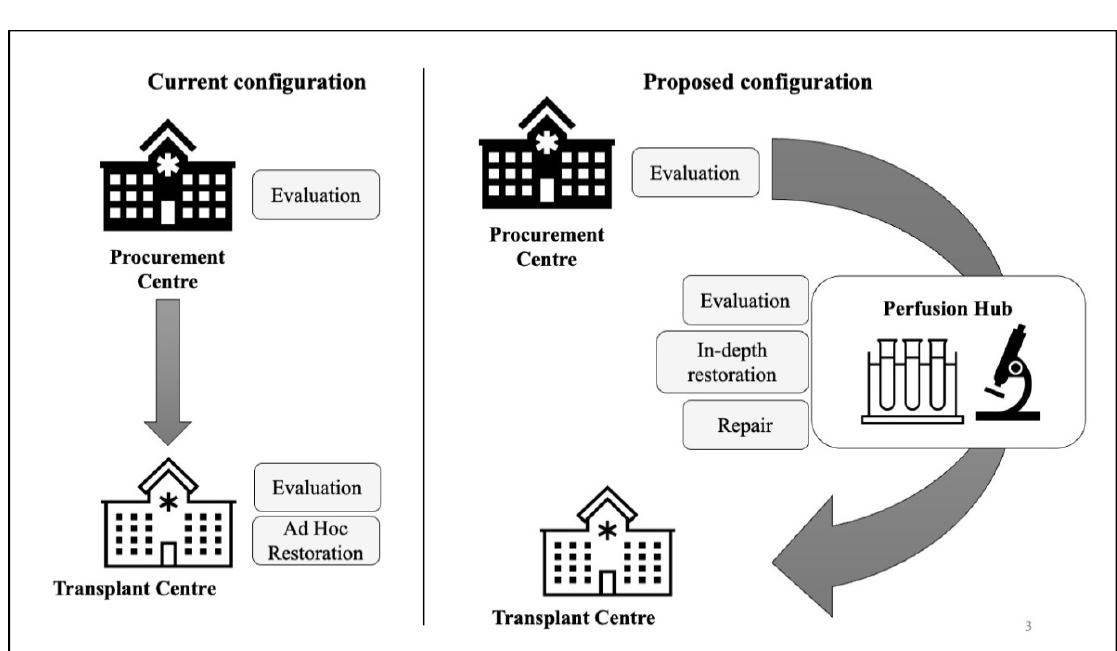
Figure 5. Proposed organ-management algorithms for transplantation. Top : Decision-making algorithm based on the quality of the organ to be transplanted. Depending on the quality of the organ, and thus its degree of damage, it could be directed towards adapted management protocols, notably at the level of the donor in the event of characterization of this quality as soon as brain death, but also once the removal has been carried out with a wide range of technical and molecular options. Bottom : proposal for the organization of the organ pathway towards perfusion centers, allowing an ad hoc evaluation of the organ and the implementation of high-quality preservation/repair protocols, thanks to the concentration of means.